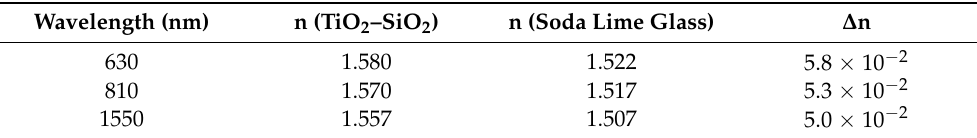
Table 3. Refractive index (n) obtained for TiO 2 –SiO 2 films and soda-lime substrates. The corresponding ∆ n is given for the three wavelengths of interest: 630, 810 and 1550 nm.